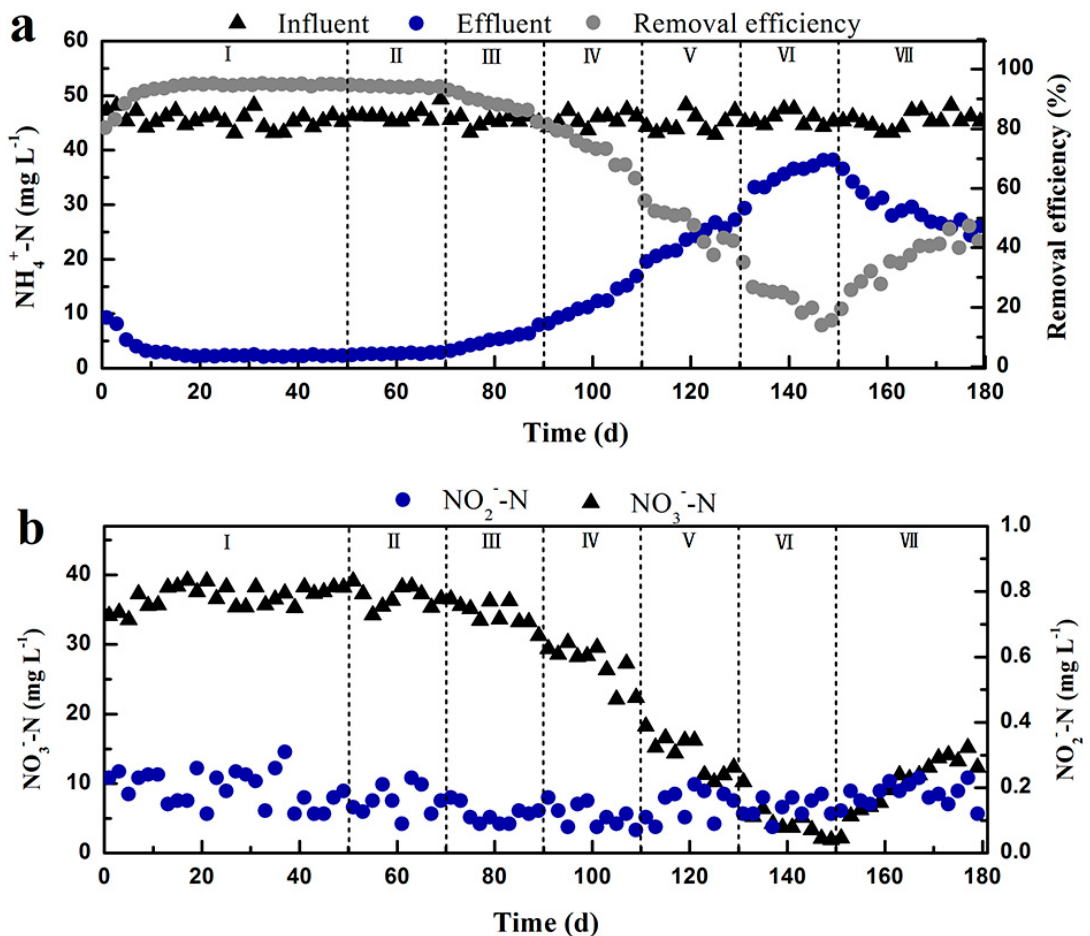
Figure 2. The variations of NH 4+ -N ( a ); NO 3 − -N and NO 2 − -N ( b ) concentrations in the influent and effluent at different Cr(VI) concentrations. The Cr(VI) concentrations were 0, 0.1, 0.2, 0.3, 0.4, 0.5, and 0 mg L − 1 , corresponding to the phases I, II, III, IV, V, VI, and VII, respectively.